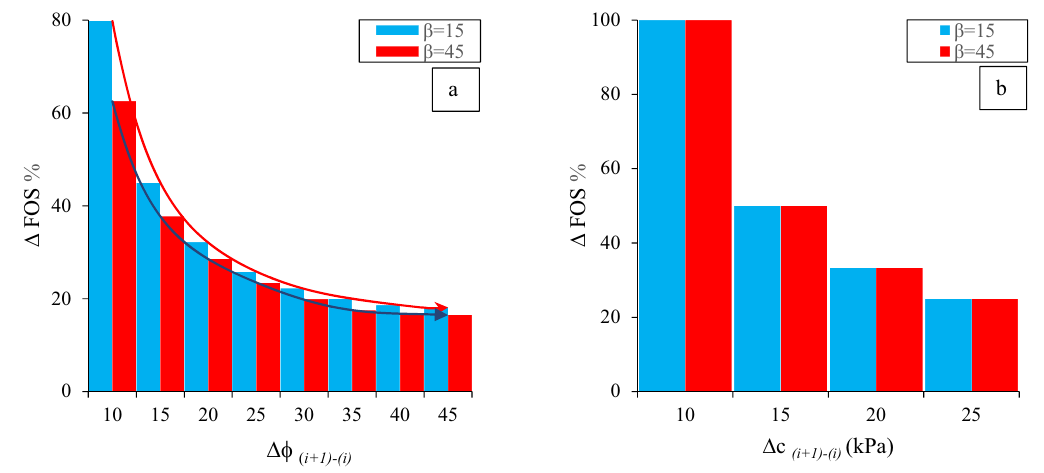
Figure 5: Rate of increase in FOS% due to NM enhancement for each 5 interval increase in ( a ) ϕ and ( b ) c .